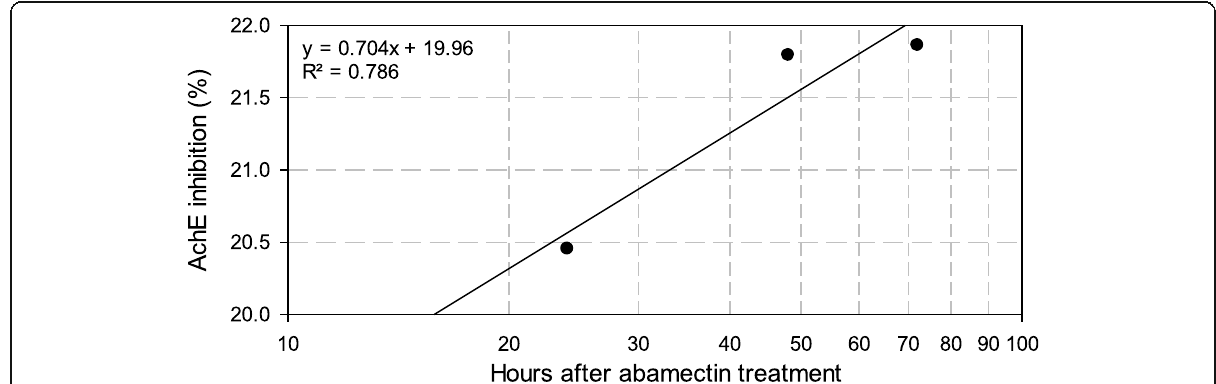
Fig. 1 Inhibition of AChE activity in Bactrocera zonata pupae treated with